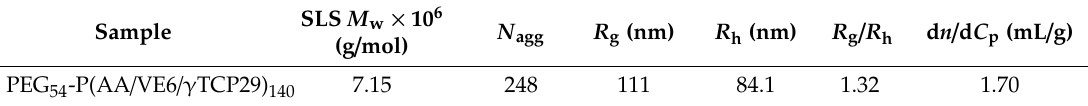
Figure 6. Debye plot for PEG 54 -P(AA / VE6 / γ TCP29) 140 in PBS at fixed C p ( = 0.10 g / L). K , optical constant; C p , polymer concentration; R θ , difference between Rayleigh ratio of solution and solvent; and θ , scattering angle. Table 2. Dynamic and static light-scattering data of PEG 54 -P(AA/VE6/ γ TCP29) 140 in PBS.